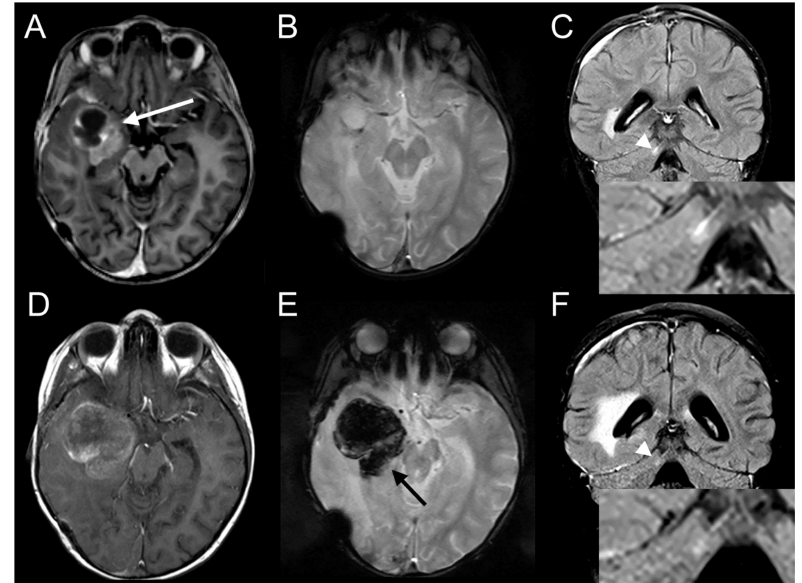
Figure 7. The target lesion is sensitive to the targeted therapy with ceritinib. MRI before therapy with ceritinib ( A – C ) showing a right sided solid mesiotemporal tumor ( A , white arrow) with a cystic component, as well as a contrast media enriching metastatic lesion within the cerebellar folia ( C , FLAIR post-contrast media, white arrow head). After 30 days of ceritinib ( D – F ), the metastatic lesion was regredient ( F , FLAIR post-contrast media, white arrow head), and hemorrhagic transformation ( E , T2*, black arrow) of the tumor was